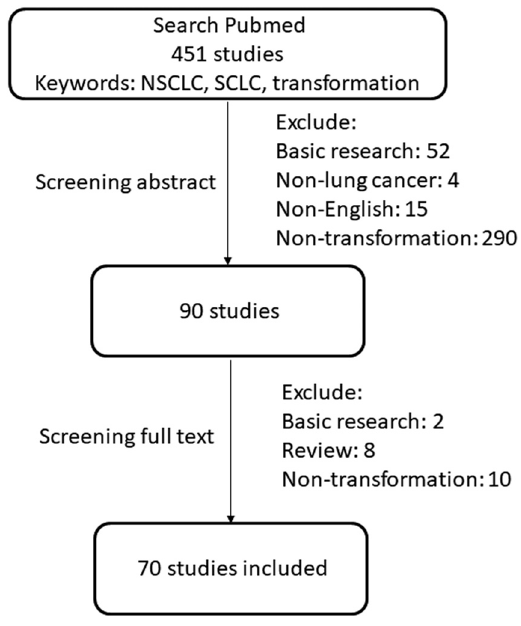
Figure 1: The retrieval fl ow chart.